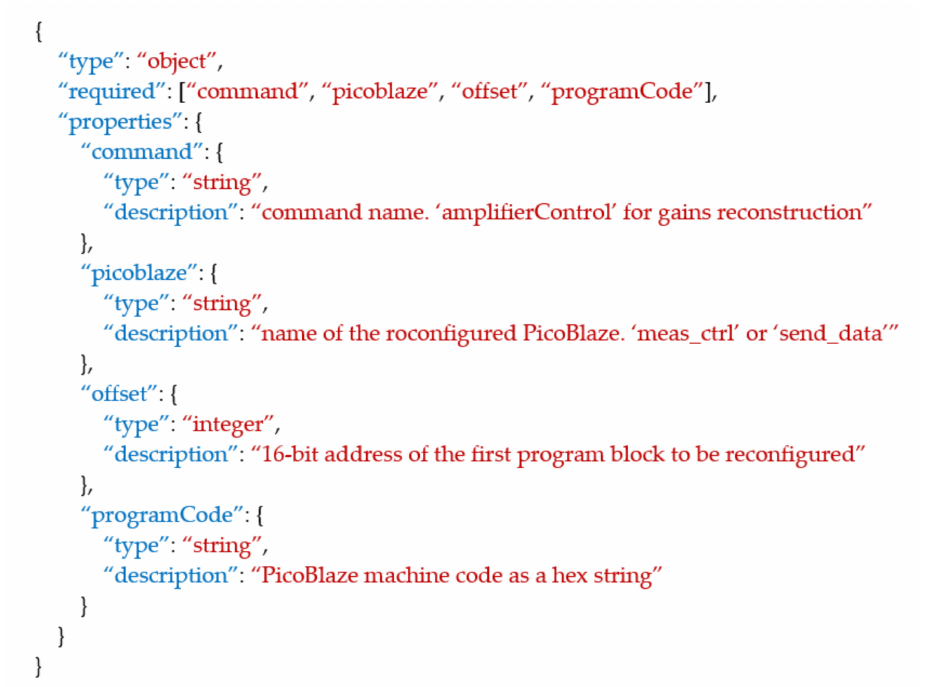
Figure 8. Structure of upper layer communication protocol command for reconfiguration.